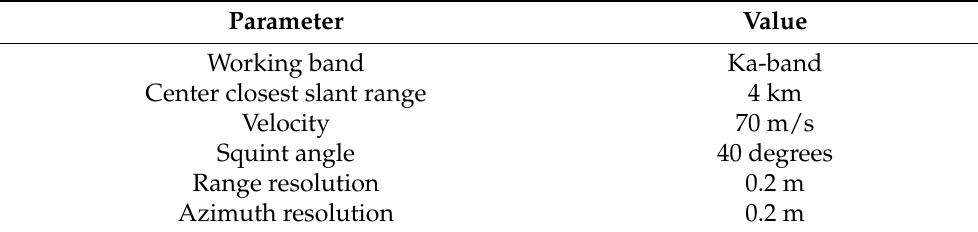
Table 3. System parameters.